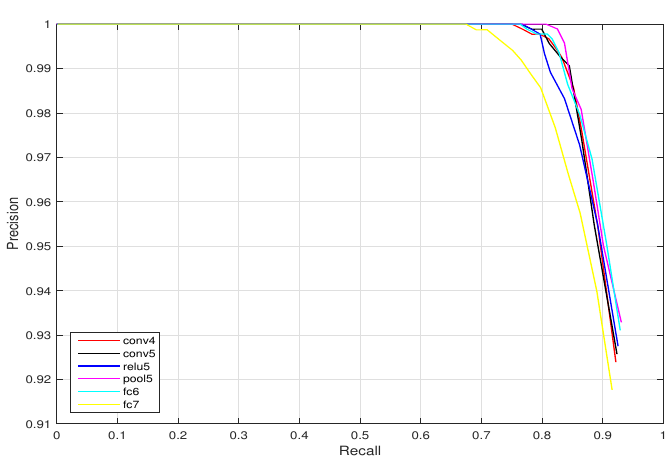
Figure 12. Precision-recall curves for the City Center data set (the trajectory acrosses city and parking areas) ( d s =